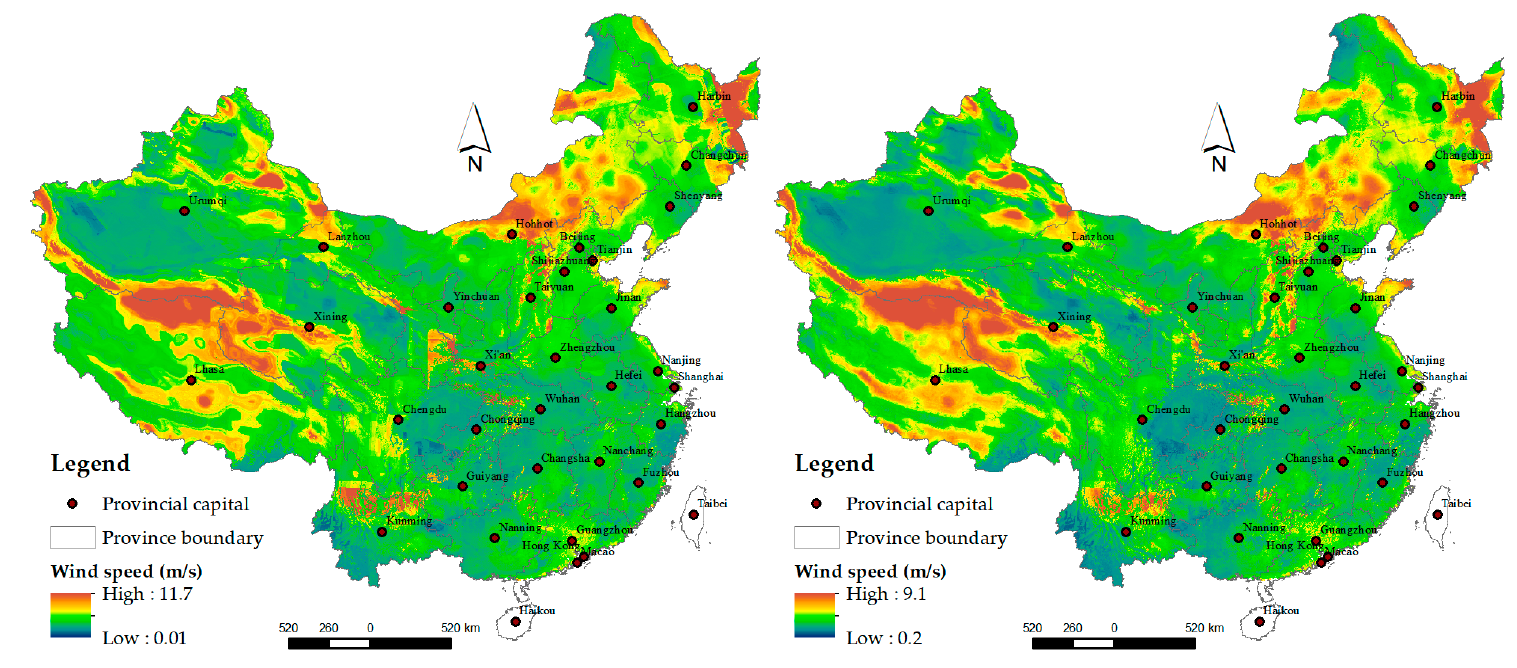
c. Predictions by random forest d. Ensemble predictions by GWR. Figure 9. Predictions at a height of 10–12 m above the ground by individual models ( a ) for autoencoder-based deep residual network, ( b ) for XGBoost and ( c ) for random forest) and their ensemble predictions by GWR ( d ) for wind speed of 1 January 2015.